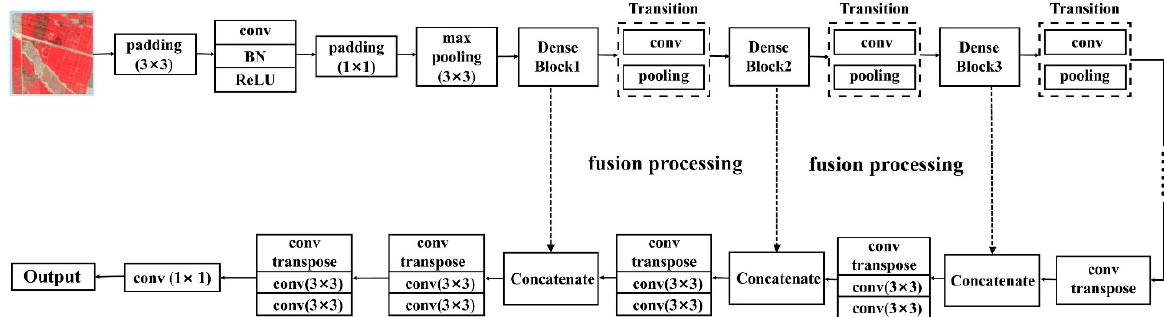
Figure 3. The improved network architecture of semantic identification based on the DenseNet model.